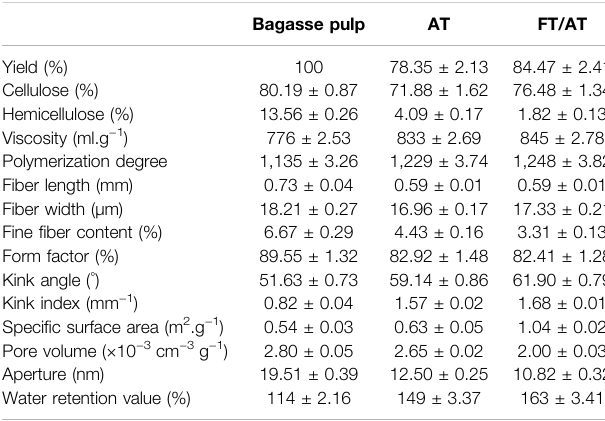
TABLE 1 | Chemical properties of bagasse fi ber with different treatments. Bagasse pulp AT